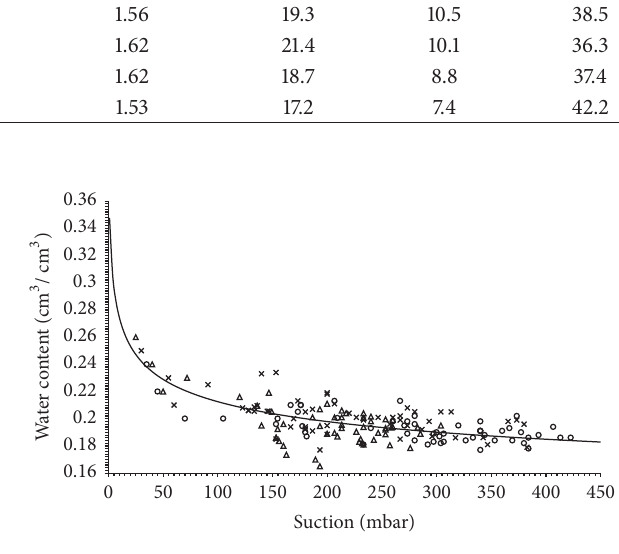
Figure 3: Soil retention curve 𝜃(ℎ) fitted (solid line) against experimental data determined at 𝑍 = 10 cm ( × ), 𝑍 = 30 cm ( 󳵻 ), and 𝑍 = 50 cm (o)